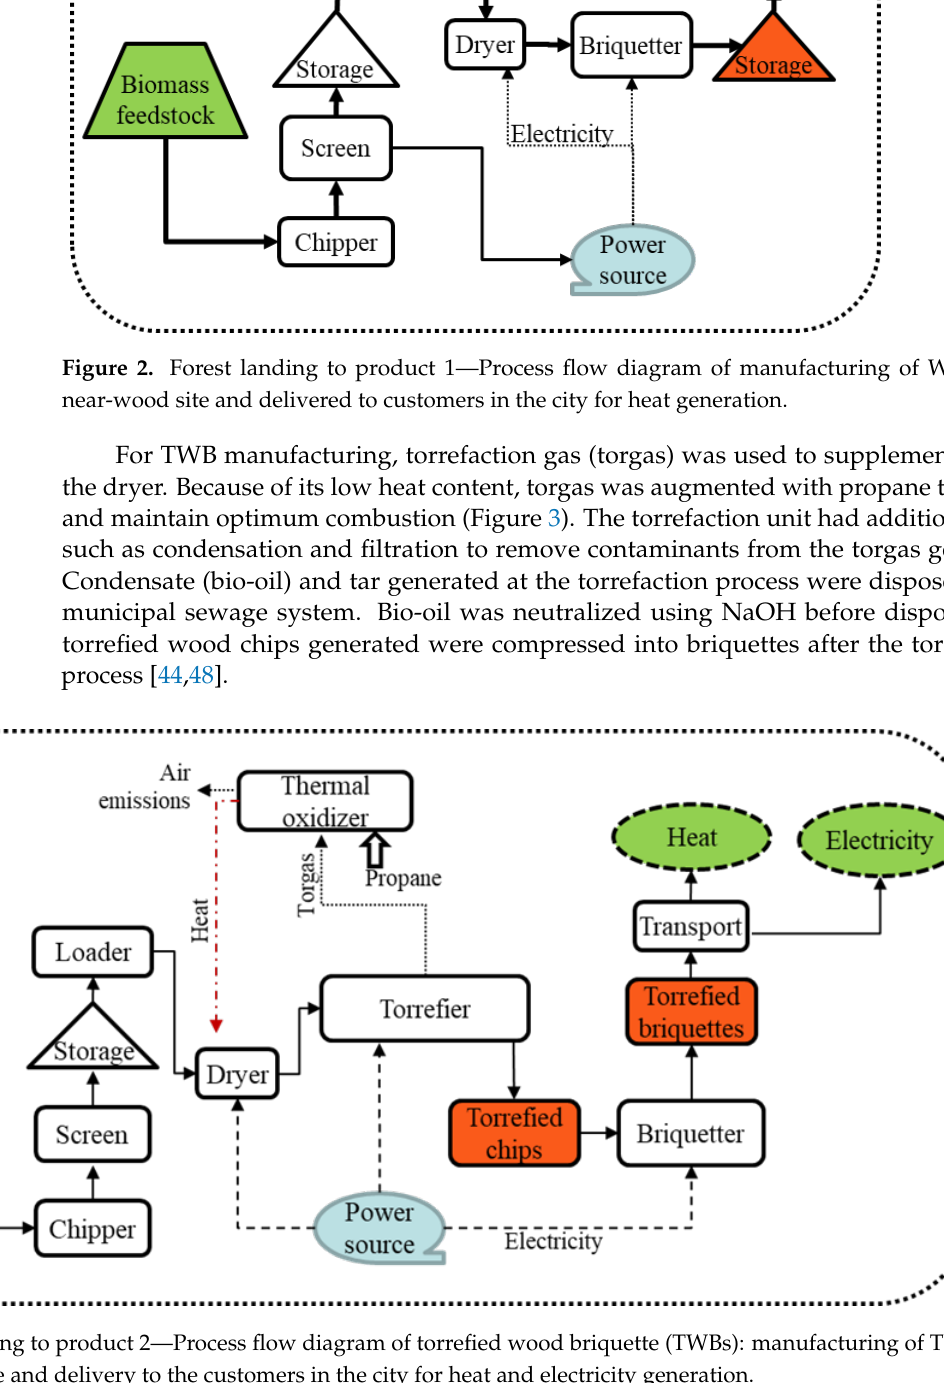
Figure 2. Forest landing to product 1 — Process flow diagram of manufacturing of WBs at the near- wood site and delivered to customers in the city for heat generation.